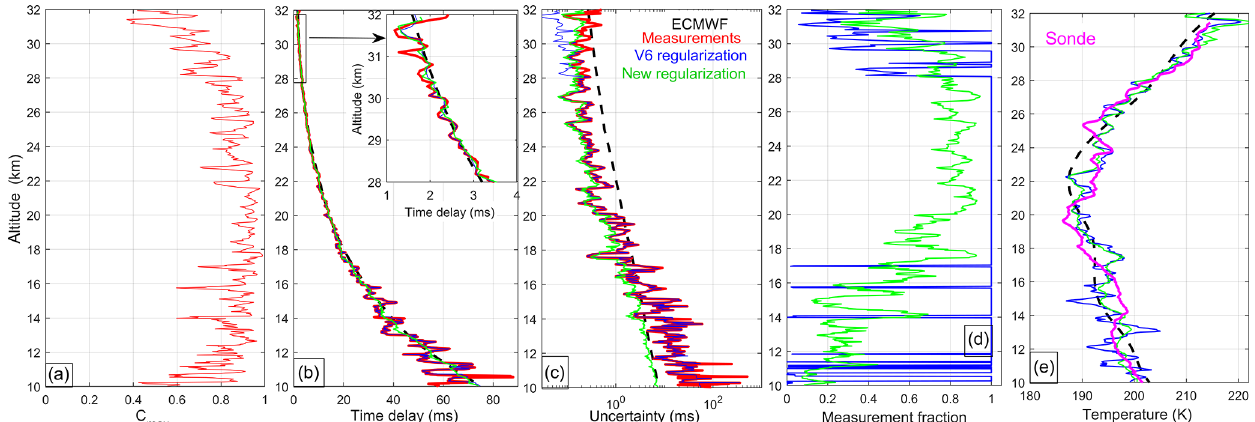
Figure 5. Illustration of time delay regularization and retrievals based on occultation R07673/S001; red: pure measurements, blue: V6 regularization, green: new (Bayesian) regularization, black: a priori profiles (ECMWF). (a) Profile of cross-correlation coefficient C max . (b) Profiles of time delay, (c) uncertainty of time delay (1 σ ), (d) measurement fraction and (e) retrieved temperature profiles and collocated sonde measurements at Marambio (magenta